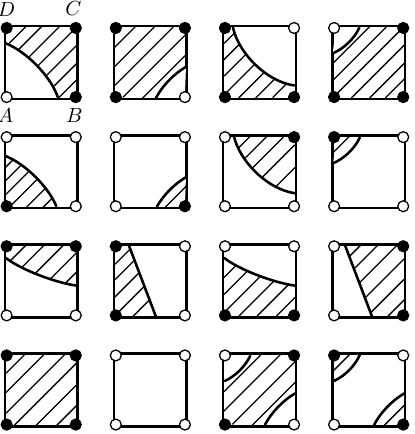
Figure 3. Illustrations of the boundaries and the above-threshold regions with the Bilinear Interpolation-Based (BIB)